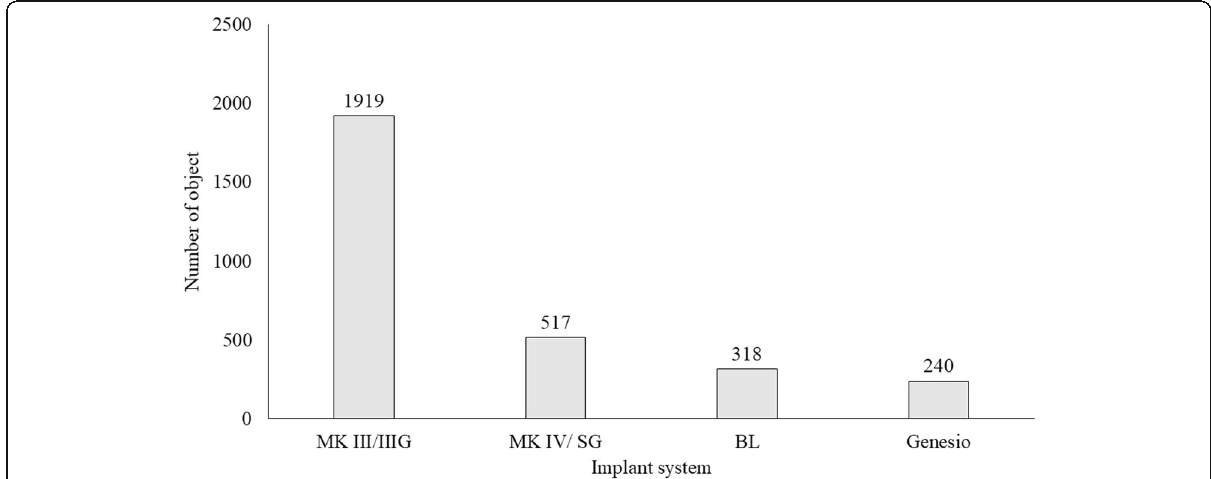
Fig. 2 Total number of objects of each implant systemin all images. MK III/MK III Groovy: MK III/IIIG, MK IV/Speedy Groovy: MK IV/SG, bone level: BL and Genesio Plus ST: